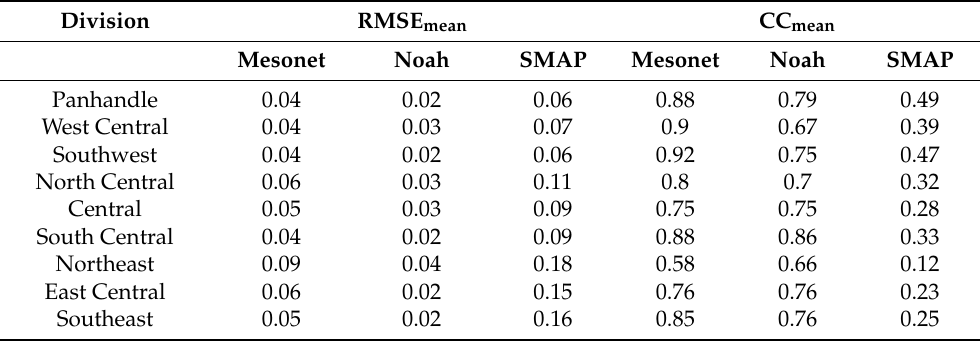
Table 4. Average CC and RMSE values obtained from the TC triplets at local 6:00 a.m. for Mesonet, Noah, and SMAP for nine climate divisions in Oklahoma. Values are similar to the 6:00 p.m.